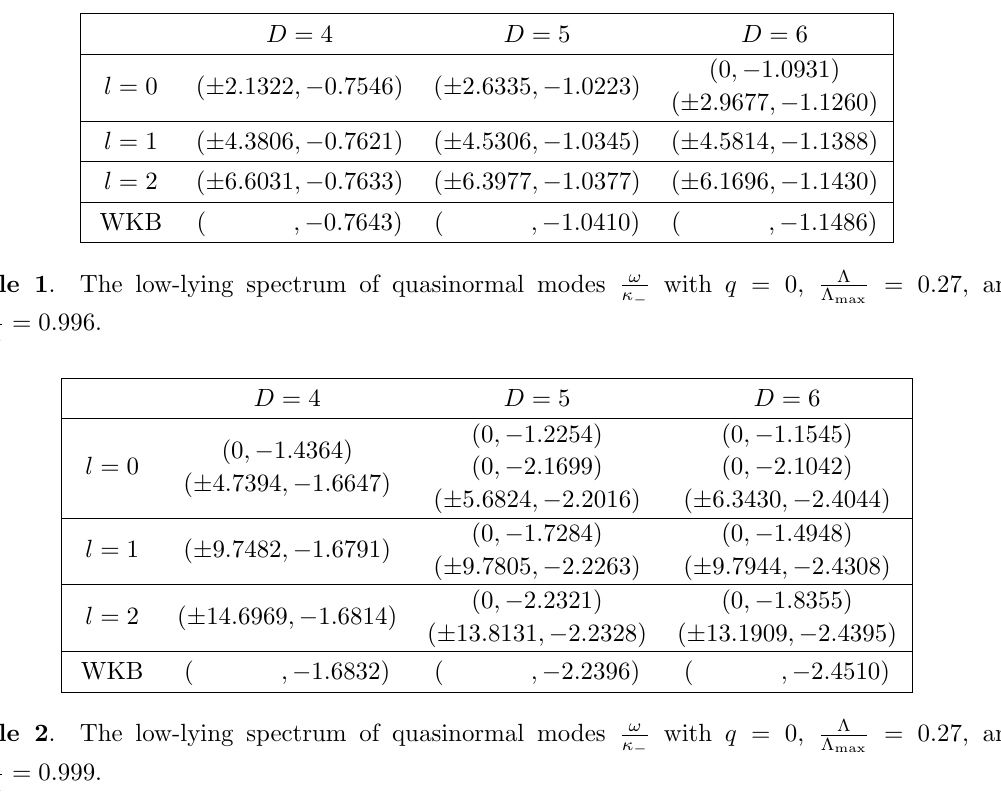
= 0 : 27, and (cid:3) max